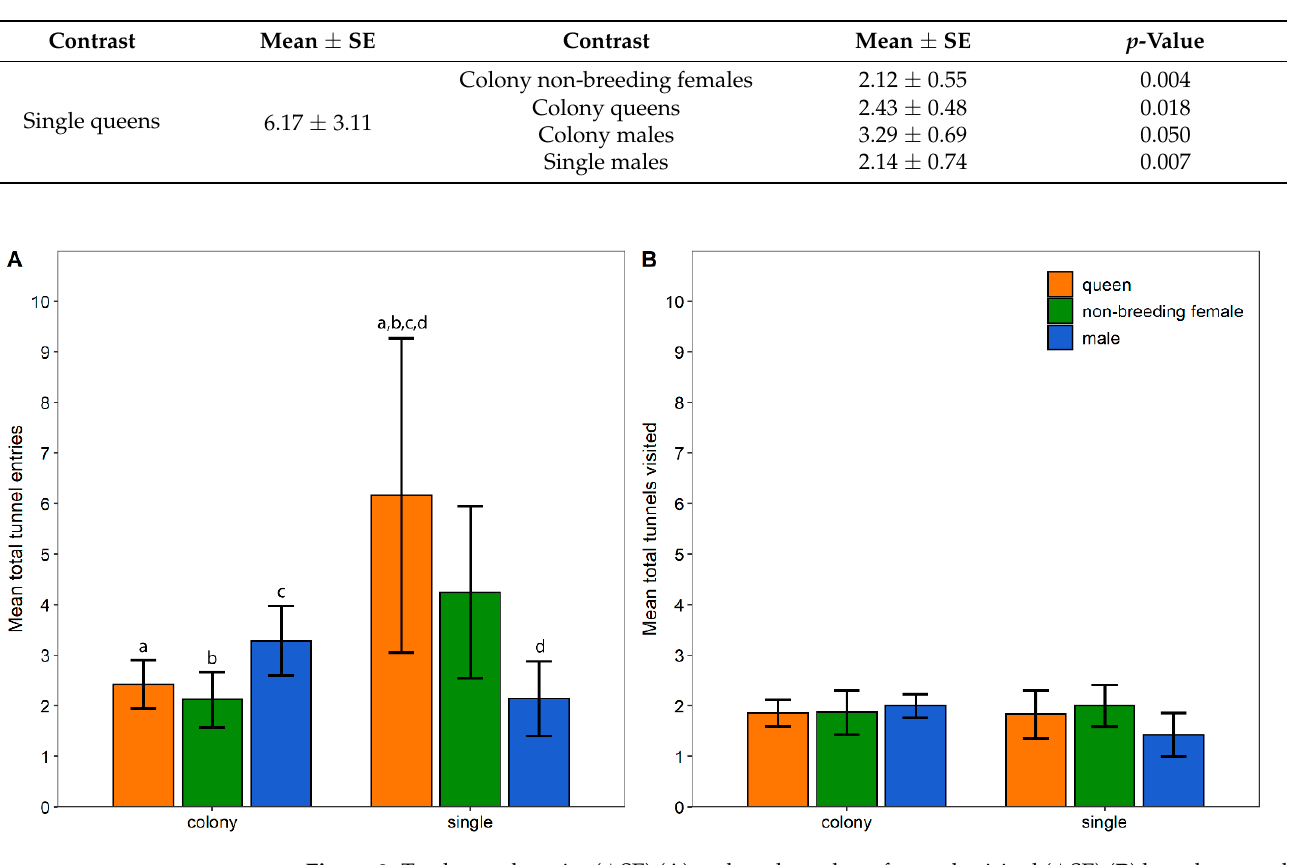
Figure 2. Total tunnel entries ( ± SE) ( A ) and total number of tunnels visited ( ± SE) ( B ) by colony- and single-housed Damaraland mole-rats in an open-field box. Significant differences between pairs are indicated by letters above the bars ( p < 0.05). Table 1. Post hoc significant differences in the mean total number of tunnel entries between exper- imental groups in Experiment 1.